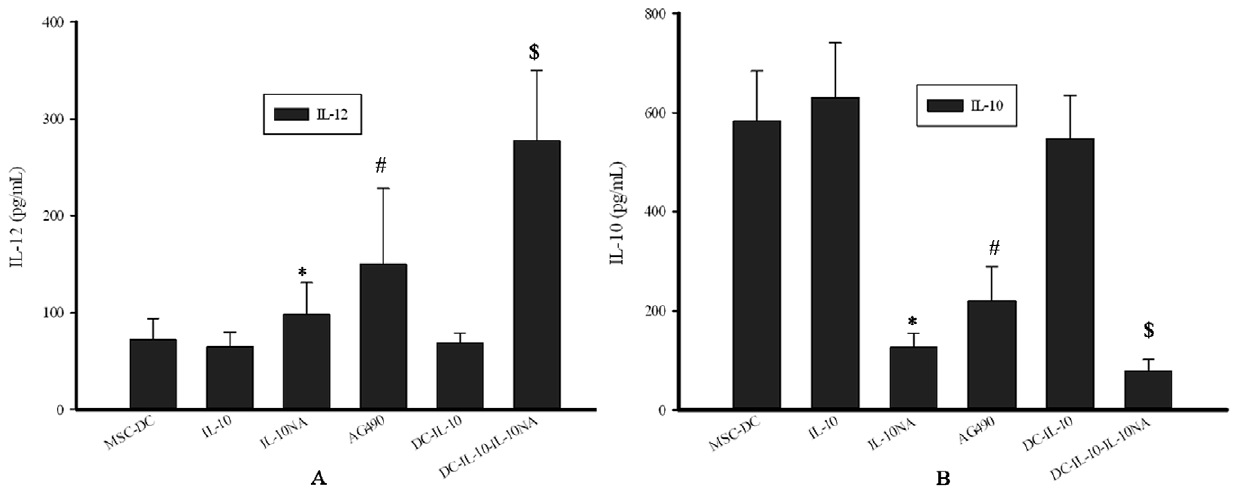
Figure 6. ELISA analysis of co-cultures of MSC-DC supplementated with exogenous IL-10, IL-10NA and JAK inhibitor (AG490). IL-10 and IL-12 levels in DC–IL-10 and DCs -IL-10 -IL-10NA group by ELISA. (A) IL-12; (B) IL-10.* P , 0.05 (IL-10NA group versus MSC-DC group), # P , 0.05 (AG490 group versus MSC-DC group), & P , 0.05 (DC- IL-10 group versus MSC-DC group), 1 P , 0.05 (DC- IL-10-IL-10NA group versus IL-10NA group),$ P , 0.05 (DC- IL-10-IL-10NA group versus DC- IL-10 group).